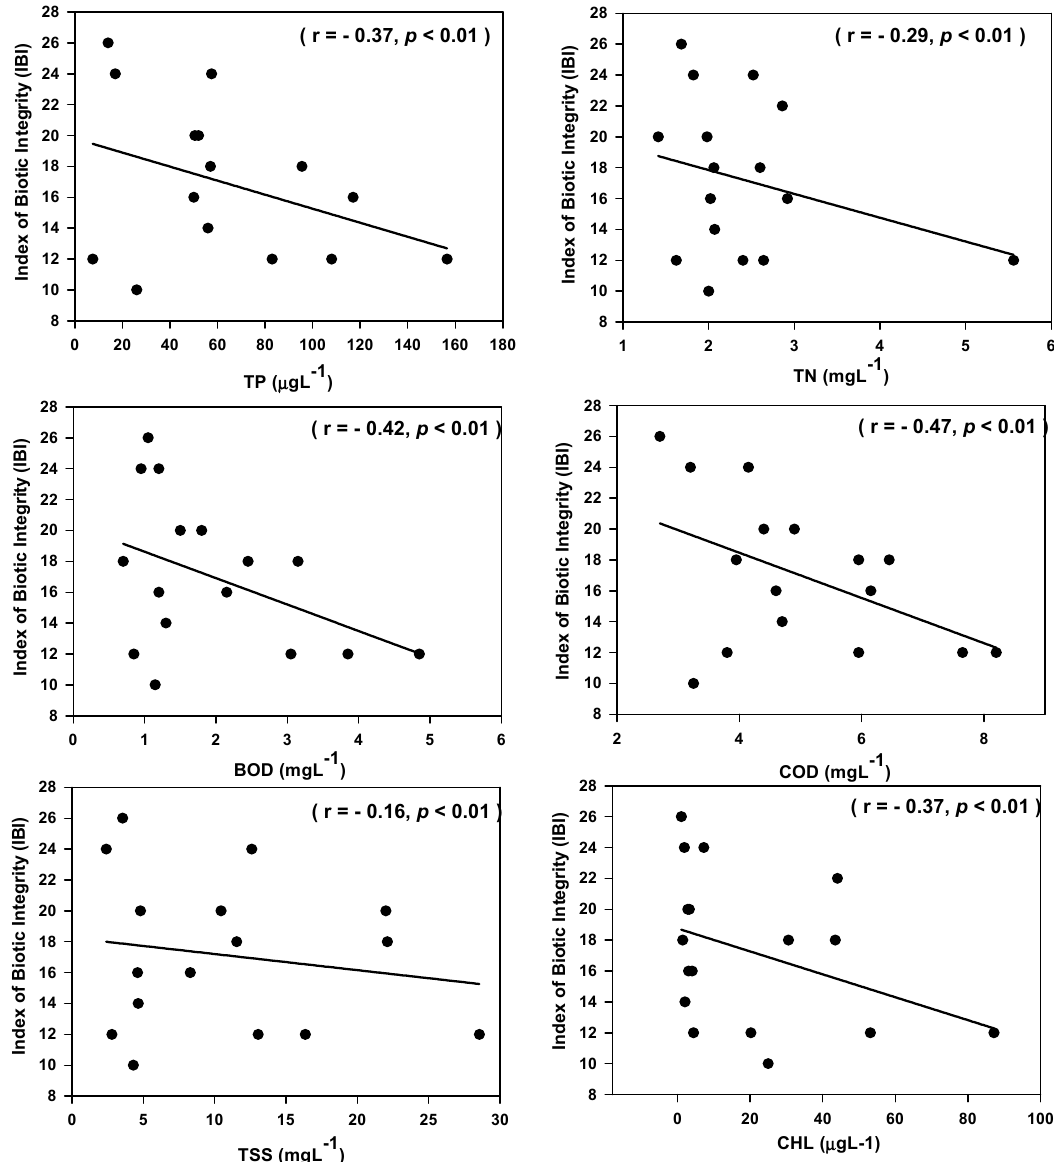
Figure 7. Index of biotic integrity (IBI) in relation to water quality parameters in the Geum River watershed (TN—total nitrogen, TP—total phosphorus, BOD—biological oxygen demand, COD—chemical oxygen demand, TSS—total suspended solids, CHL—chlorophyll).